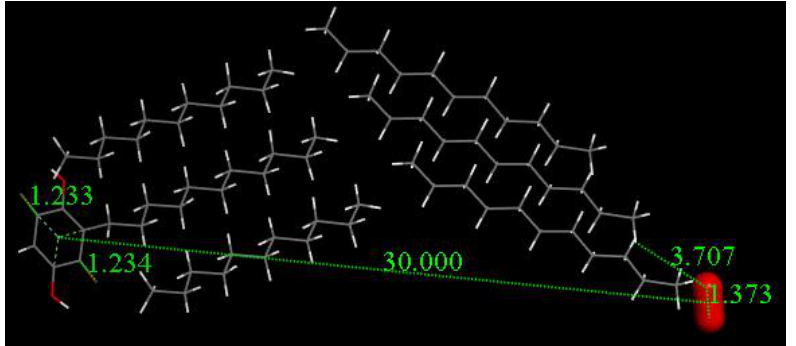
Figure 14. Embelin model for insertion in cell membrane. The superoxide molecule (d(O-O) = 1.373 Å) is posed to run a geometry minimization.